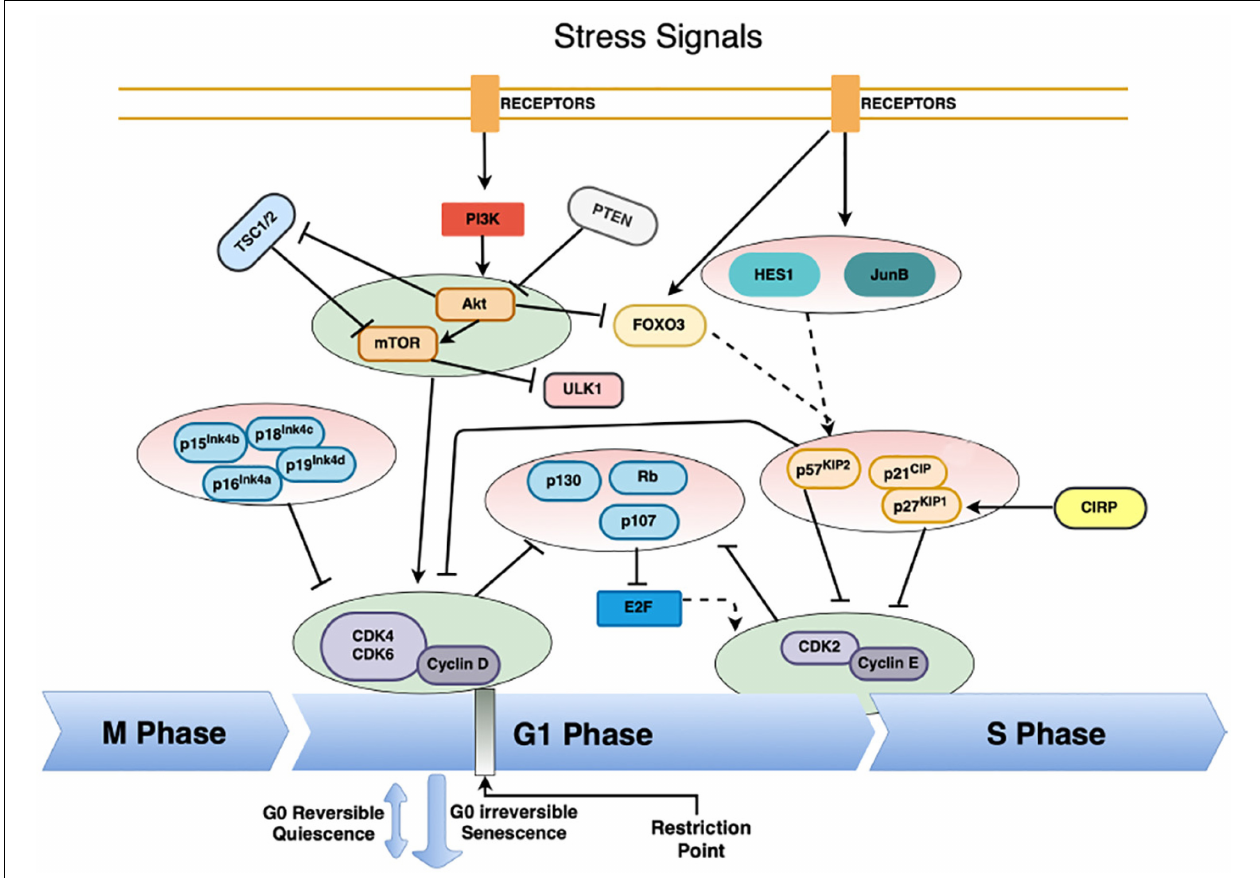
FIGURE 1 | The complex regulation of HSC – and possibly hibernators – cell cycle entry. Cyclin-CDK complexes drive the progression of the cell cycle. Their inhibition forces entry into quiescence from G 1 into the G 0 phase of the cell, mainly by the action of cyclin-dependent kinase inhibitors (CKI) from the INK and CIP/KIP family. Various pathways converge on the CKIs, thus instituting quiescence. Low activity of the PI3K/Akt/mTOR pathway is vital to enter quiescence, mainly through the inhibition of cyclin-D-CDK4/6 complexes and suppression of the Rb-E2F pathway. This pathway is massively regulated, primarily through inhibition by the tumor suppressors phosphatase and tensin homolog (PTEN) and tuberous sclerosis proteins 1 and 2 (TSC1/2). Furthermore, the activity of the cyclin D-CDK4/6 complexes is inhibited both by the Ink4 and CIP/KIP CKIs. The Cyclin E-CDK2 complex regulates progression from the G 1 to the S phase, and it is mainly regulated by the CIP/KIP family of CKIs, as well as by tumor suppressors from the retinoblastoma protein family (Rb, p107, p130). Extrinsic signals activate the transcription factors HES1, JunB and FOXO3a expression, which in turn regulate the transcription of the CIP/KIP family members. Moreover, entry into cellular quiescence is also subject to regulation via the tumor suppressor p53, as a response to cellular damage. Solid arrows indicate direct activation pathways, solid T-lines indicate inhibitory pathways and dashed arrows indicate transcriptional regulation